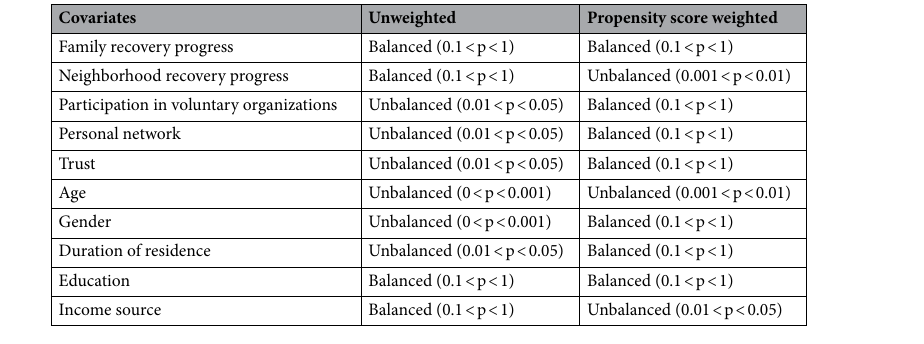
Table 2. Balance assessment for propensity score